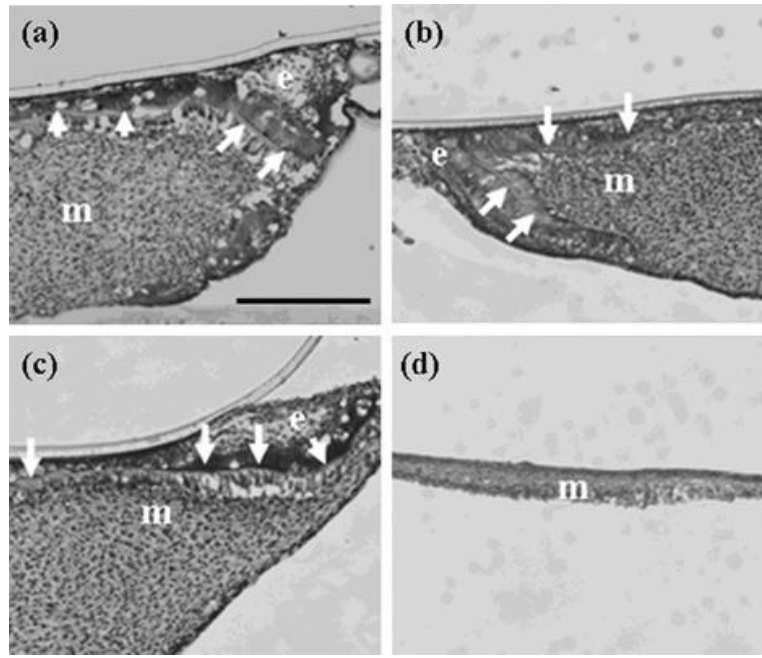
Figure 4. Histology of teeth developed from germs reconstructed with mixed epithelial cells (emtg-2 cells: EC = 1:0.75 to 0) and MT cultured for seven days on inserts. ( a , b ) All reconstructed germs (emtg-2 cells: EC = 1:0.75, 0.5) developed teeth. ( c ) Half of the germs (emtg-2 cells: EC = 1:0.25) developed teeth. Any histological difference was unrecognized among teeth developed from germs with different mixing rates (emtg-2 cells: EC = 1:0.75, 0.5 and 0.25). ( d ) No teeth developed from germs reconstructed with emtg-2 cells and EC (1:0) and MT. Only a thin layer of mesenchymal cells was recognized, e: epithelium, m: mesenchyme, arrows: very thin dentin- (cid:79)(cid:76)(cid:78)(cid:72)(cid:3)(cid:86)(cid:87)(cid:85)(cid:88)(cid:70)(cid:87)(cid:88)(cid:85)(cid:72)(cid:15)(cid:3)(cid:54)(cid:70)(cid:68)(cid:79)(cid:72)(cid:3)(cid:69)(cid:68)(cid:85)(cid:3)(cid:76)(cid:86)(cid:3)(cid:20)(cid:19)(cid:19)(cid:3)(cid:541)(cid:80)(cid:3)(cid:76)(cid:81)(cid:3)(cid:11) a ) and all figures are at the same